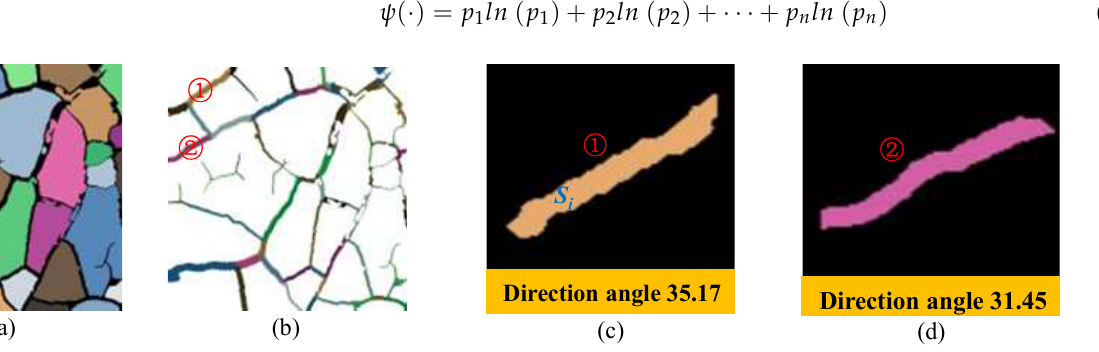
Figure 3. Information on crack development. ( a ) Soil block segmentation. ( b ) Crack network identification. ( c ) Crack image with a direction angle of 35.17. ( d ) Crack image with a direction angle of 31.45.